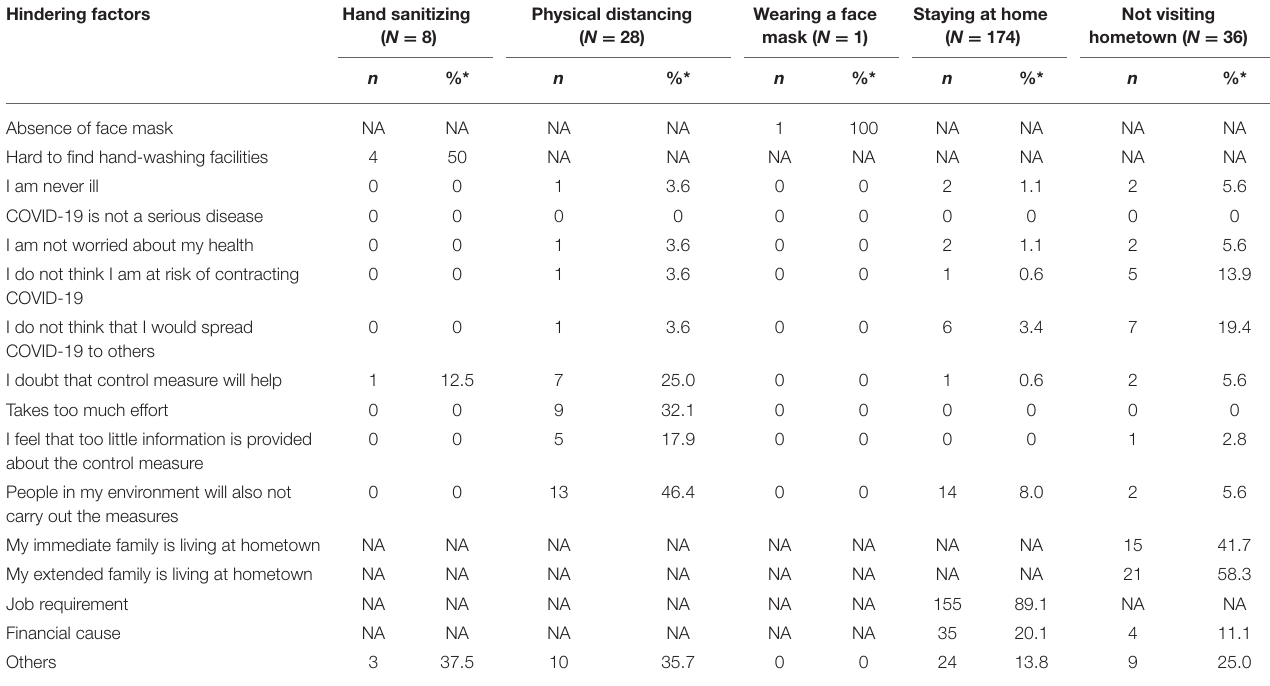
TABLE 2 | Hindering factors that hinder the willingness to carry out preventive measures of COVID-19 in Indonesia. Hindering